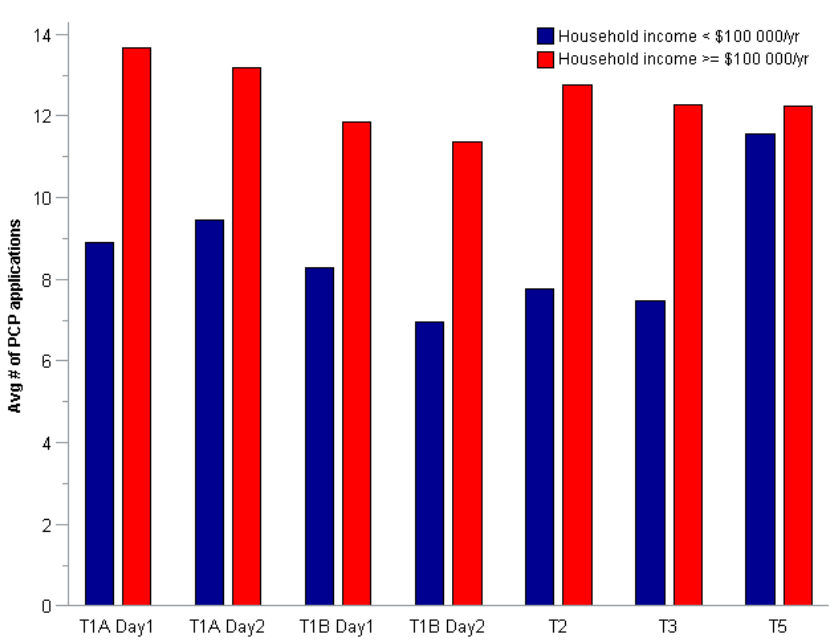
Figure 3. Average number of PCP applications per participant by income and 24 h study period.